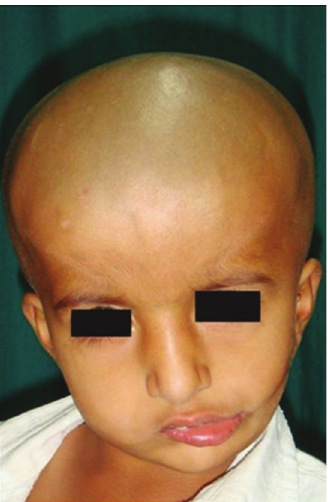
Figure 1: Preoperative frontal view.